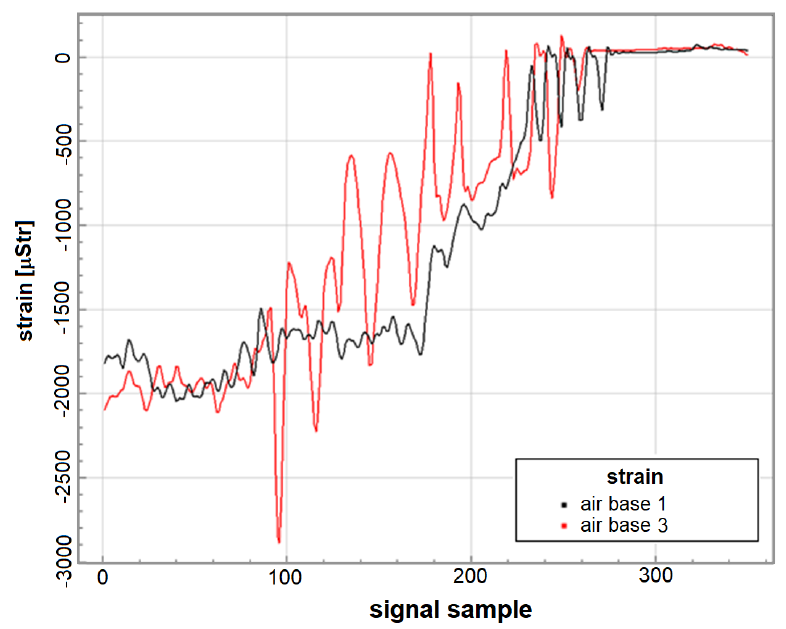
Figure 18. Records of strain during take-off for selected flights from the home base and air base no.